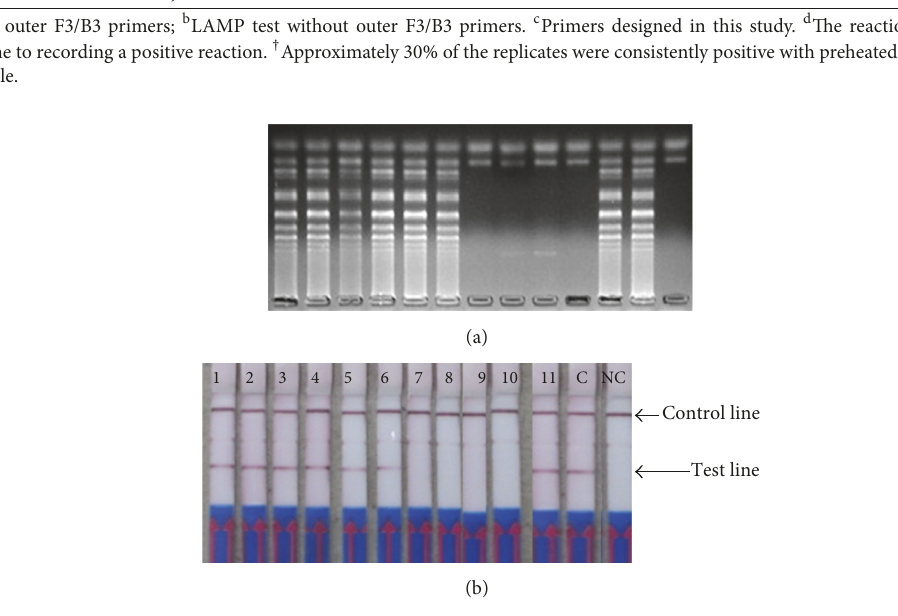
Figure 1: The detection Cryptosporidium spp. using the stem LAMP amplification product (220 bp) using 2.0% agarose gel stained with ethidium bromide and LFD format. The genomic DNA was prepared from specimen collected from children presenting with diarrhea. The faint line between the test line and the positive control line is nonspecific binding at DIG test line because the strips were done to detect two products. 1 = MB407, 2 = MB419, 3 = MB491, 4 = MB501, 5 = MB502, 6 = M1492, 7 = M1599, 8 = M009, 9 = M016, 10 = M044, 11 = M074, C